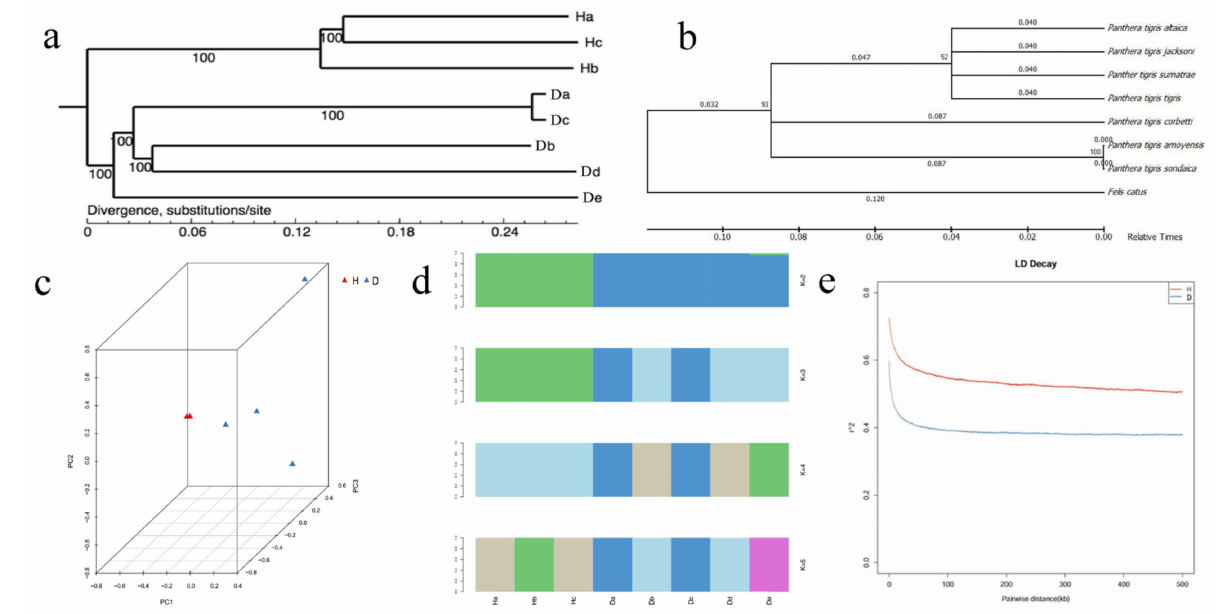
Figure 2. Divergence between the Amur tiger and the South China tiger. ( a ) Phylogenetic relationship analysis of eight tiger breeds. ( b ) Phylogenetic relationship among the Panthera tigris . ( c ) Three- dimensional principal component analysis. ( d ) Population structure. Each column in the picture represents an individual, and the length of the different color fragments represents the proportion of an ancestor in the individual genome. ( e ) Decay of linkage disequilibrium (H: the South China tiger; D: the Amur